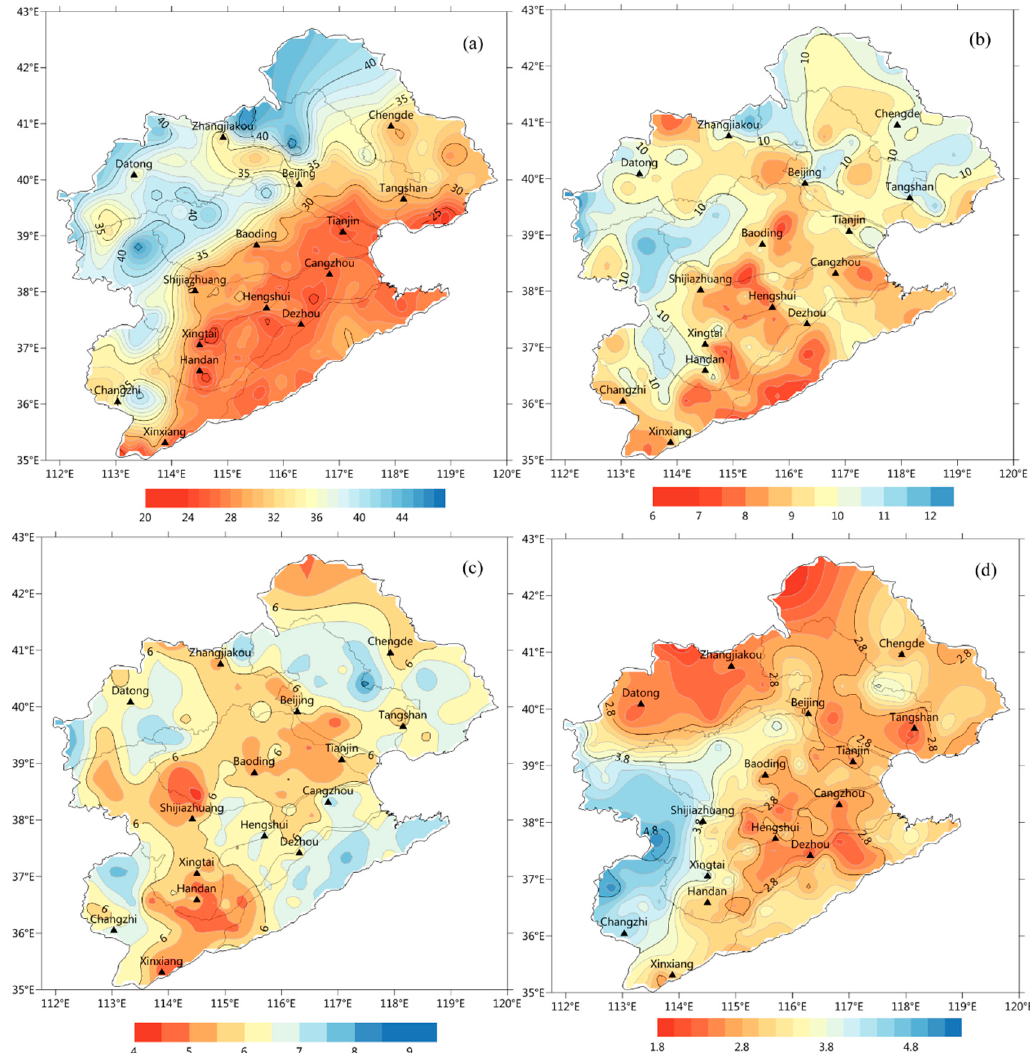
Figure 9. The precipitation frequency with different durations in the Haihe River basin, 2007–2017 (unit: hour) (( a ), short-duration (1–3 h) precipitation; ( b ), medium-duration (4–6 h) precipitation; ( c ), long-duration (6–12 h) precipitation; and ( d ), continuous precipitation (over 12 h) precipitation).